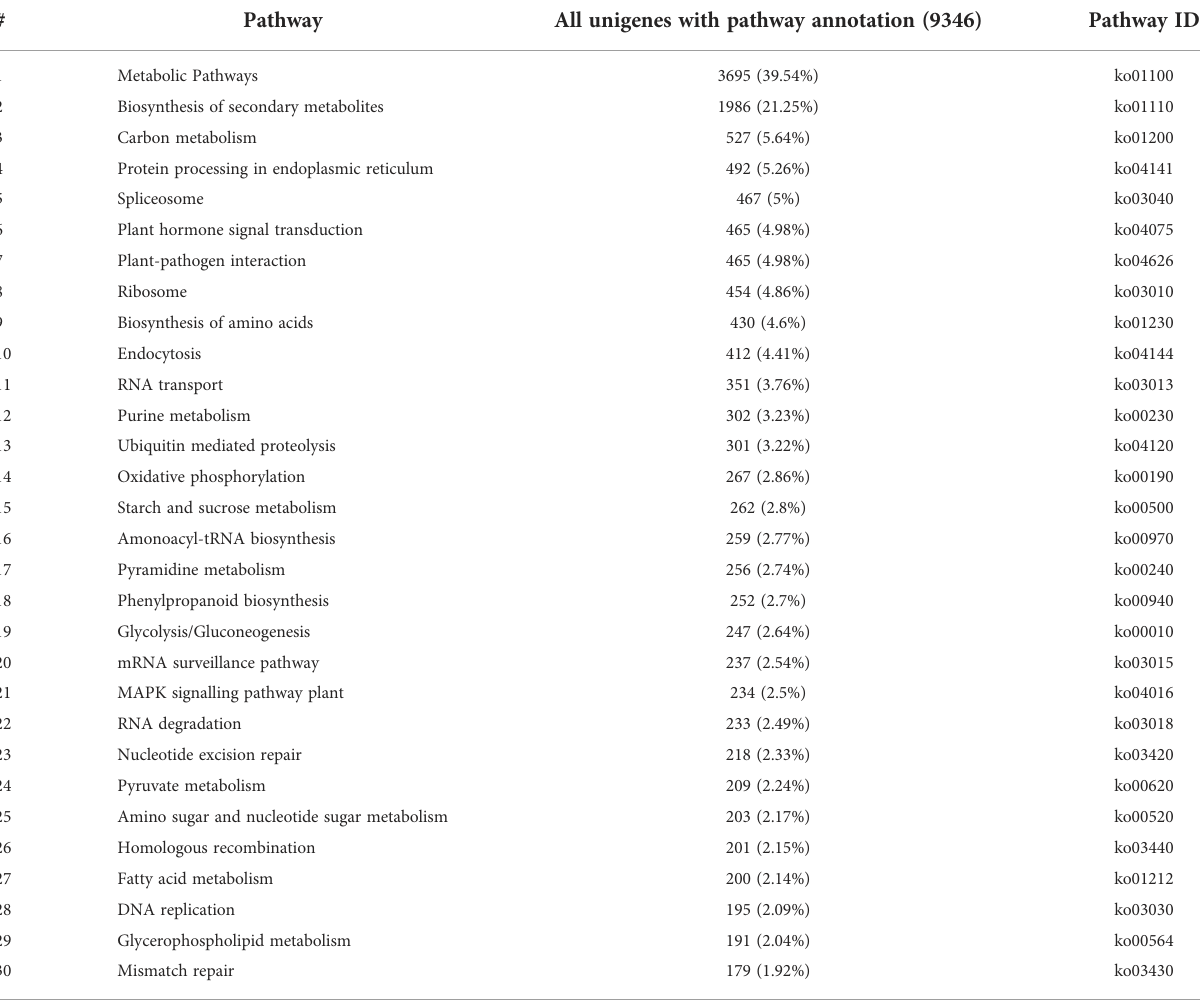
TABLE 3 Enriched KEGG pathways among the Opisthopappus longilobus